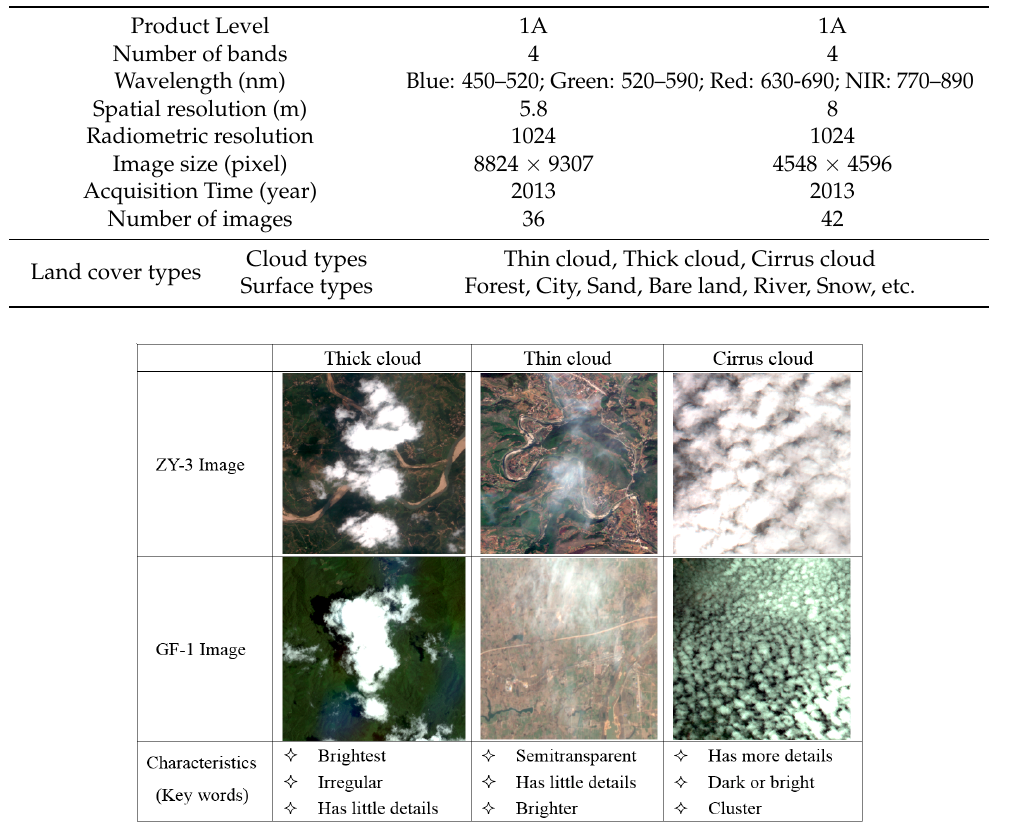
Figure 1. Graphic examples of the three types of clouds visually recognizable from remotely sensed data: thick cloud, thin cloud, Cirrus cloud.